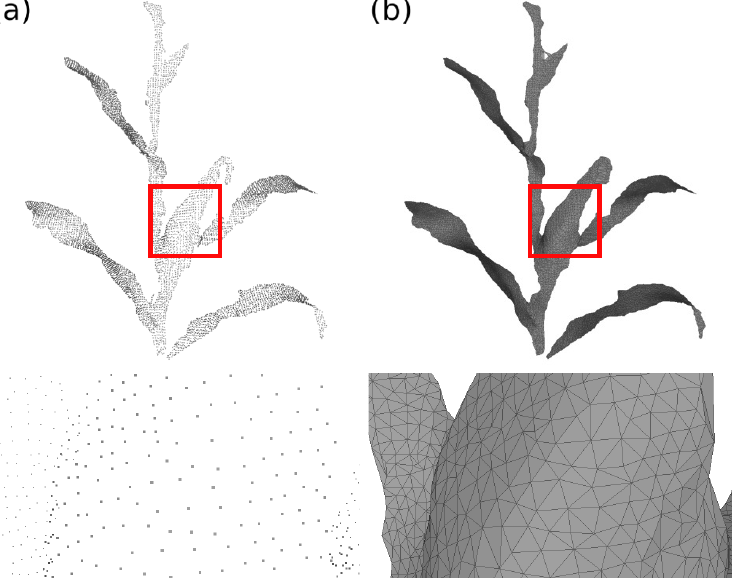
Figure 9. Advancing Front surface reconstruction. ( a ) Input point cloud and ( b ) surface reconstructed with the Advancing Front